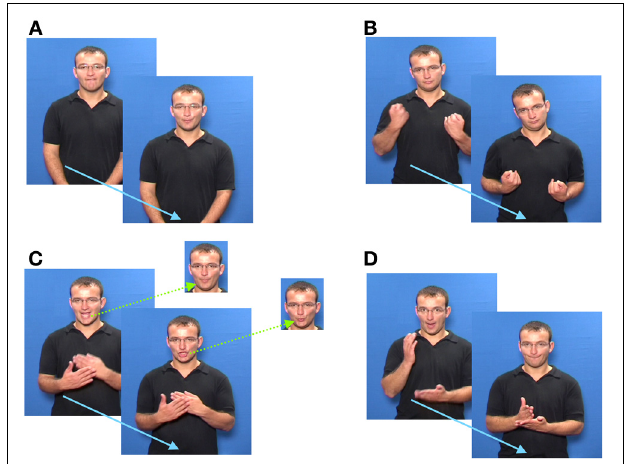
FIGURE 3 | Illustrations of stimuli. (A) SS, Silent articulation of the English word “football.” The fricative (/f/)(“foot..”), and the semi-open vowel / c :/ (“..ball”) are clearly visible. (B) Man, The BSL sign ILL. (C) DM, The BSL sign ASIAN shows the mouthing of /e I / and / /. The face insets show the corresponding parts of the mouthings for the manual homonym BLUE, where /b/ and /u:/ can be seen. (D) EP, The manual sequence for [TRUE] requires abrupt movement from an open to a closed contact gesture. As this occurs, the mouth closes abruptly.